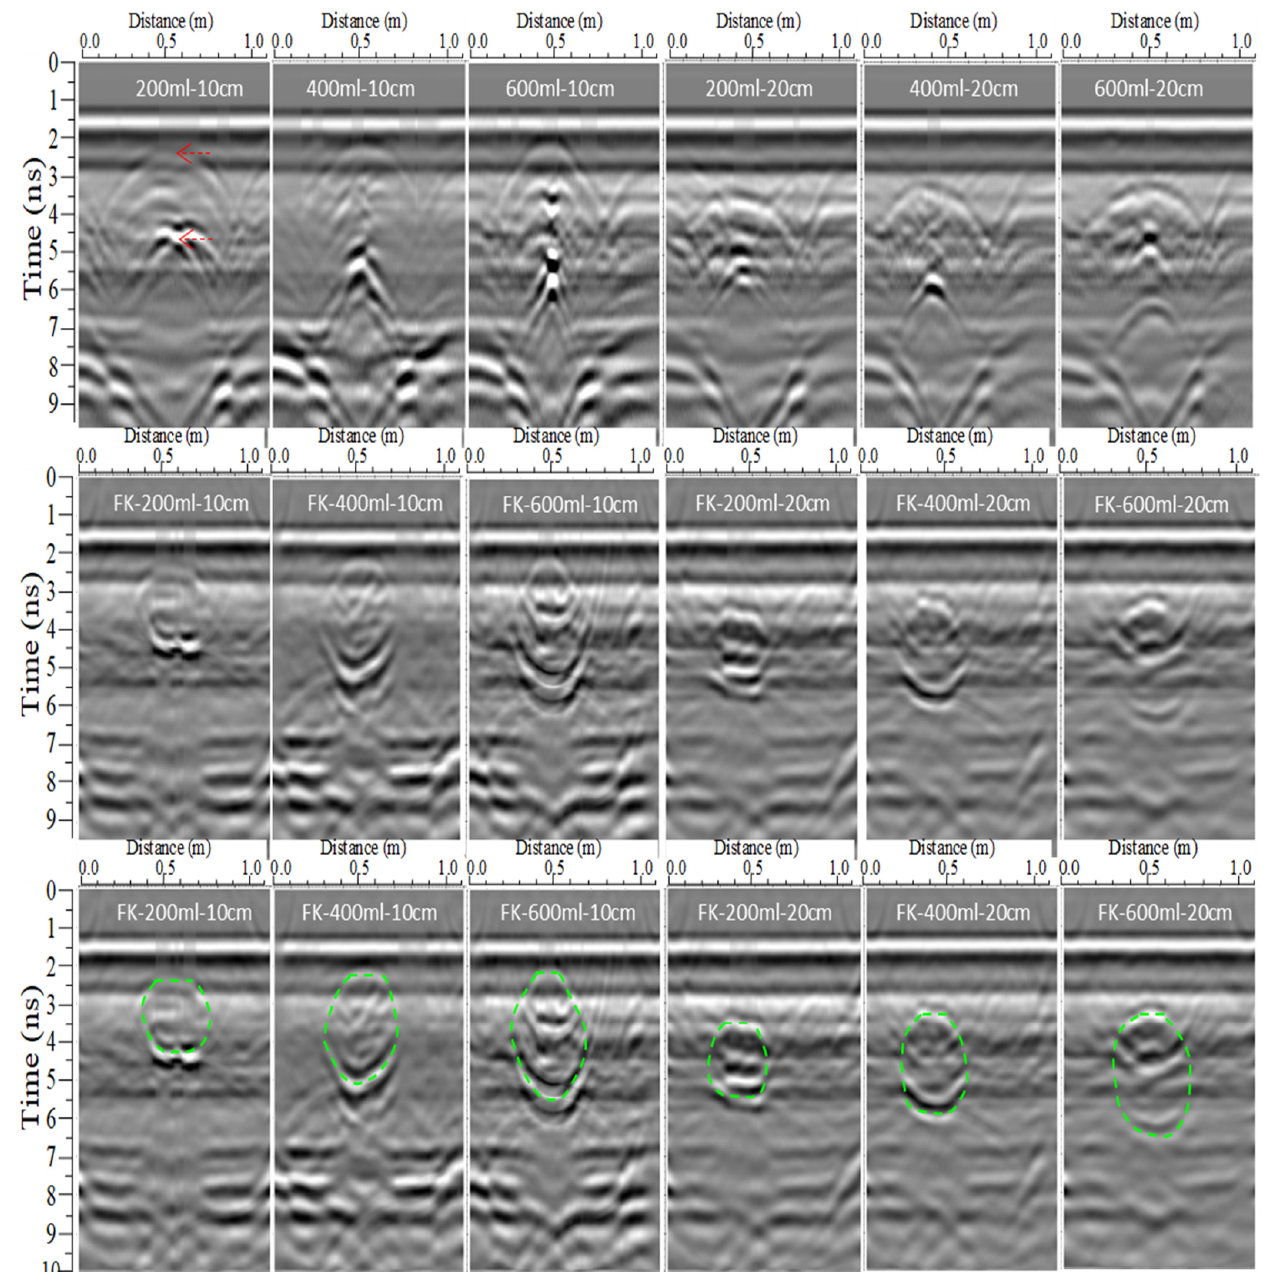
Figure 14. Longer scan line radargrams of the moistube irrigation SWB. The SWB reflections are more complicated than the simulated data due to the irregular shape of the SWBs. Indeed, there is much clutter because of the uneven reflections in the real SWBs, which indicates that the dielectric properties of the SWBs are inconsistent, further implying that the soil moisture content varied within the SWBs. This can be proven by the measured moisture content results. The moisture content was not exactly the same in the upper, middle, and lower positions in the wetted body, which can be seen in Table 4. Thus, the top interface of the SWBs generated strong reflections, which reached the GPR receiver directly with little clutter due to the homogeneous dry soil. Meanwhile, when the EM waves propagated through the wetted body, they were scattered and superimposed. As a result, the reflection signals were different in direction and intensity, which looked messy and disordered in the GPR